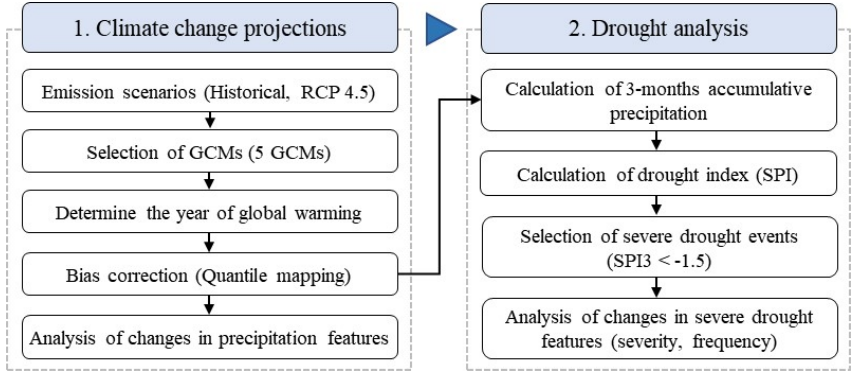
Figure 1. Modeling procedure used in this study.